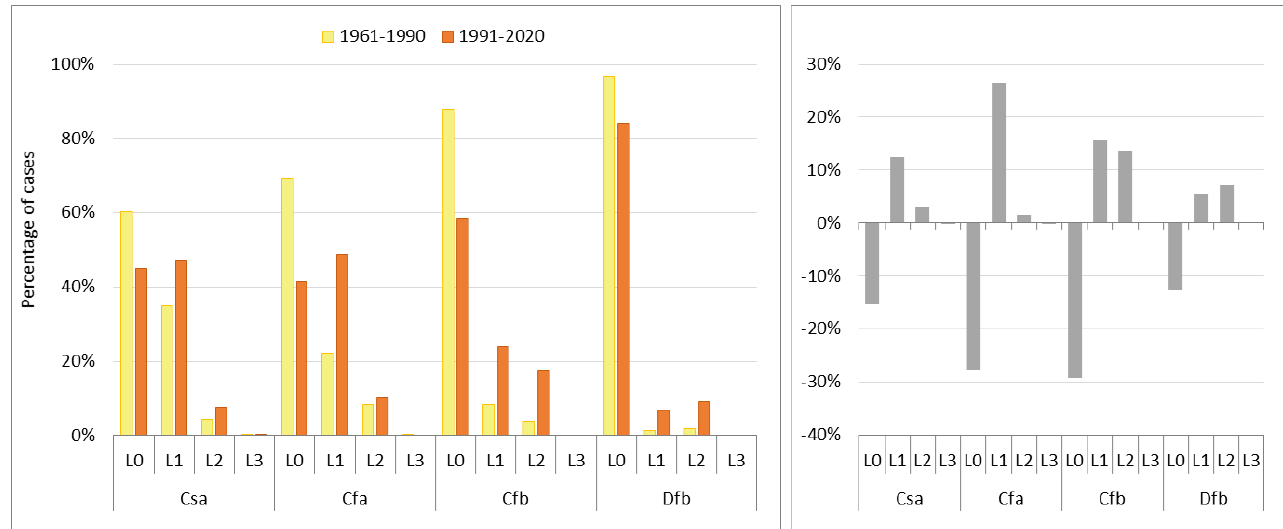
Figure 7. Left panel: Mean EHF sev across SEE by severity levels according to Nairn et al. [37] for periods 1961–1990 and 1991–2020 by climate zones. Right panel: Percentage change in the mean EHF sev for 1991–2020; L0—no extreme